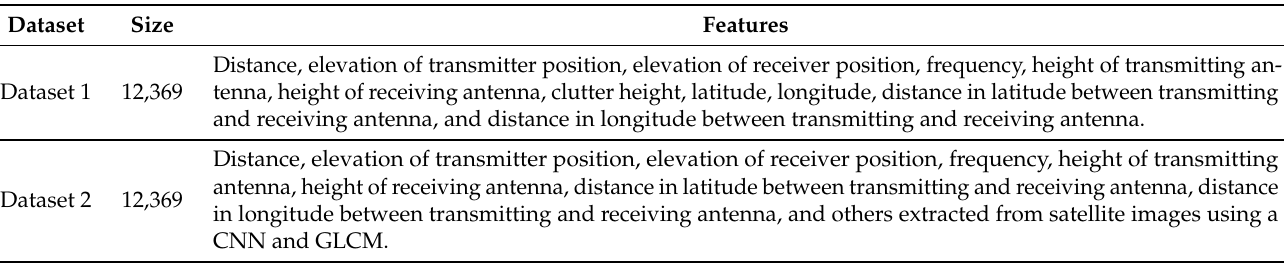
Table 2. Summary of